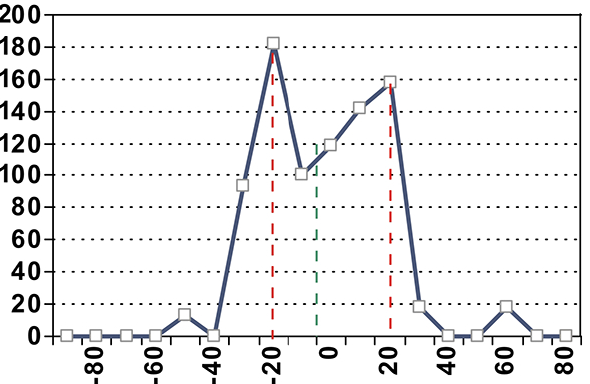
Fig. 6. Latitudinal distribution of moonquakes (total number of events – 844). The horizontal axis shows Moon latitudinal belts (10 ◦ wide), vertical axis – number of moonquakes (data from Lammlein (1977)). The green dotted vertical line corresponds to the Equator, two peaks of the seismic activity on the Moon marked by red dotted vertical lines.